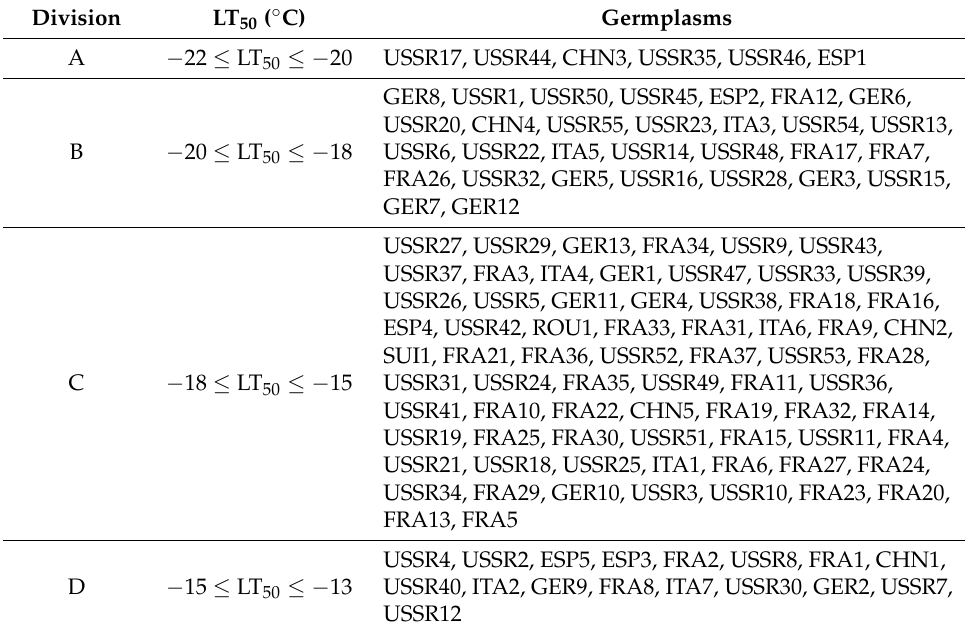
Table 5. Wine grape hardiness regionalization in